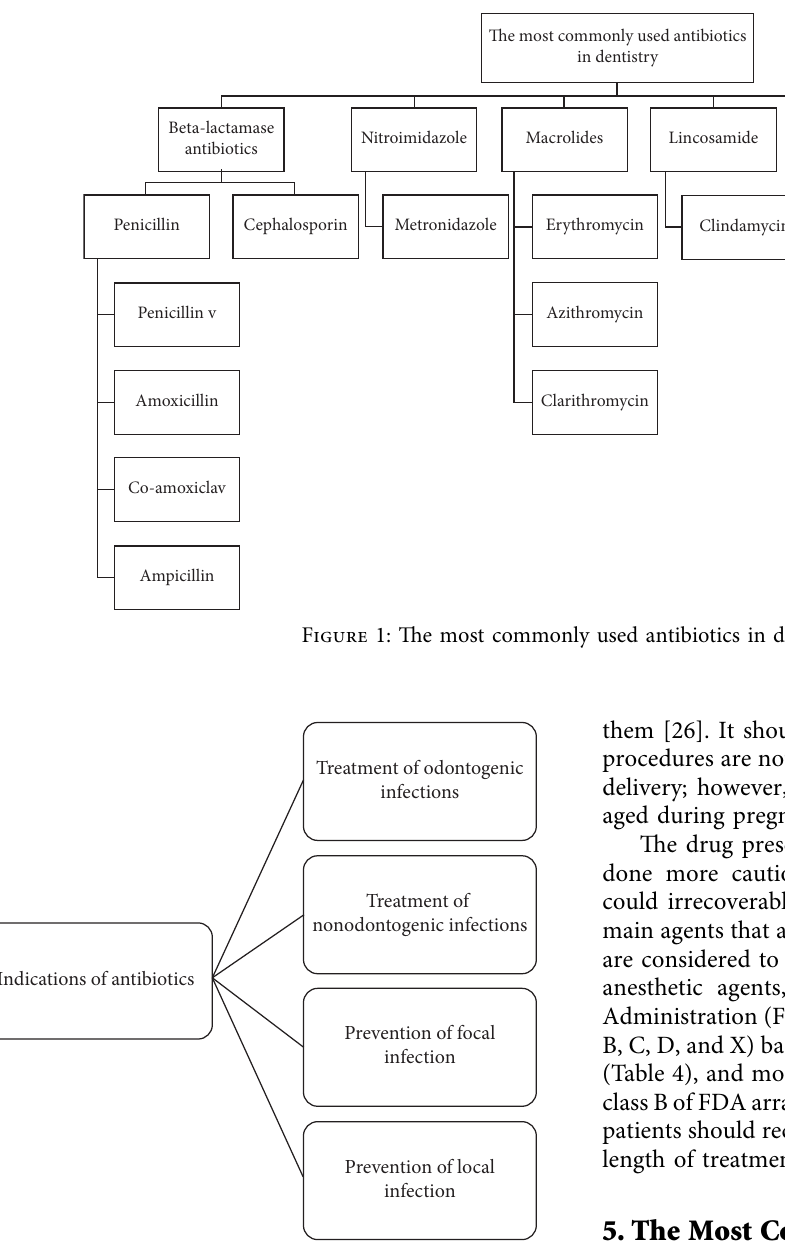
Figure 2: Indications of antibiotics in dental practice.